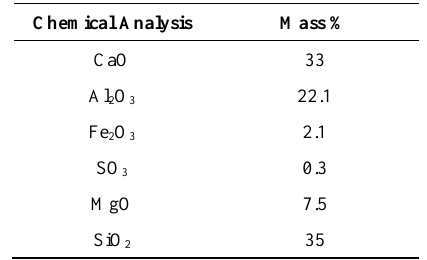
Table 1. Chemical composition of Alccofine-1203.